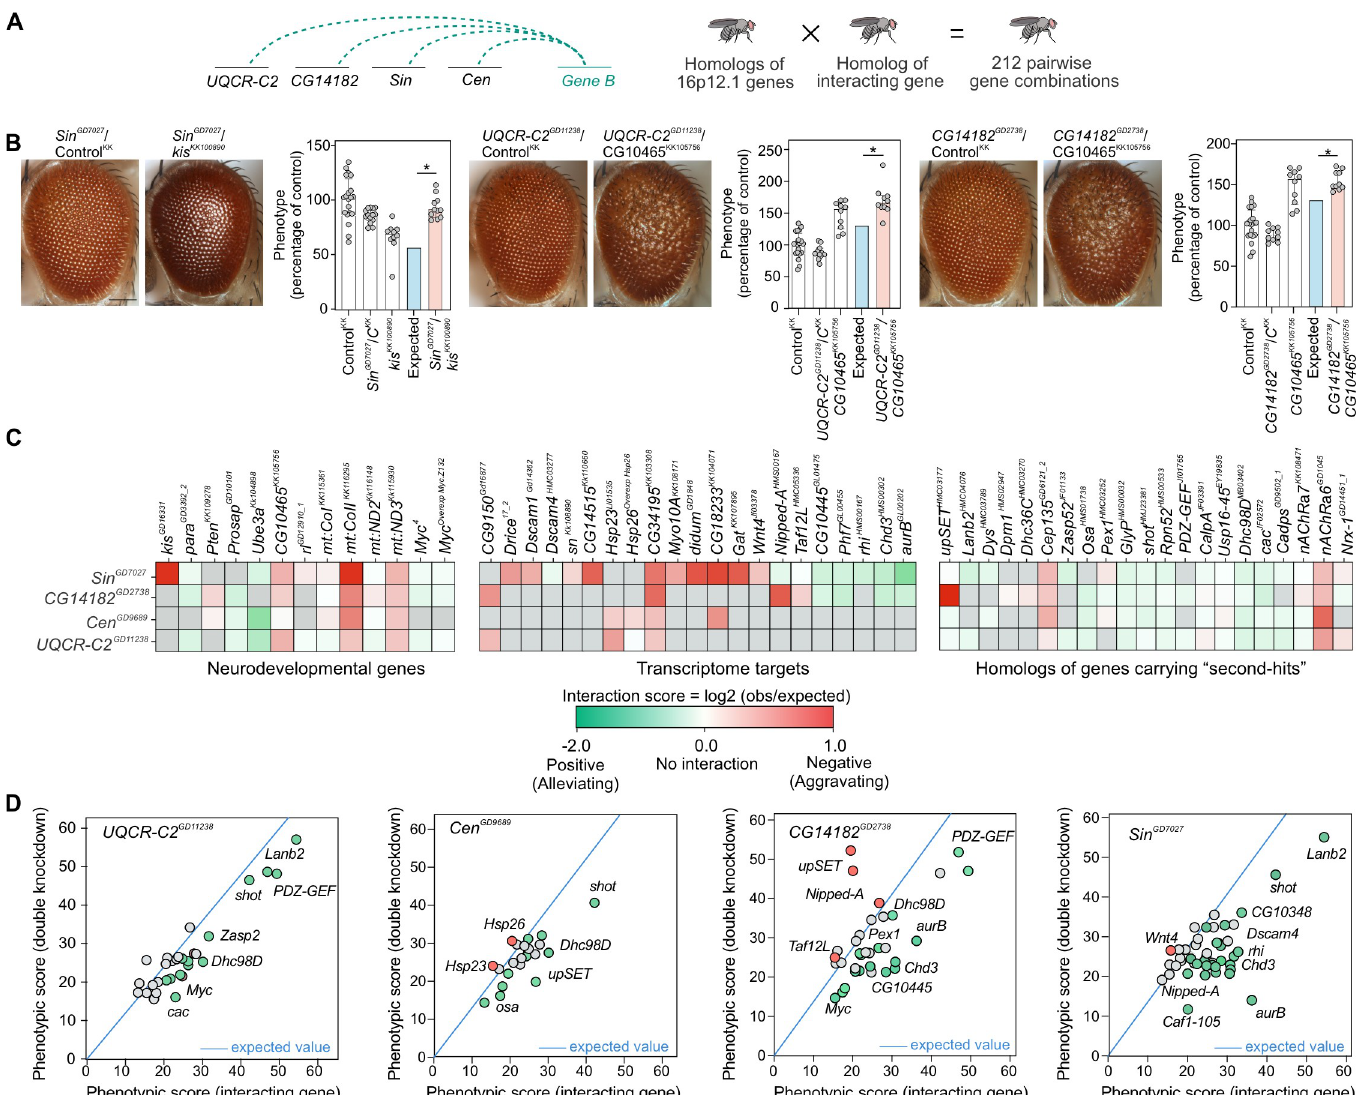
Fig 4. Homologs of 16p12.1 genes show complex interactions with conserved neurodevelopmental genes and homologs of patient-specific “second-hit” genes. (A) We evaluated how homologs of genes outside of the CNV region ( Gene B ), including genes carrying “second-hit” variants in children with the 16p12.1 deletion, genes within conserved neurodevelopmental pathways, and transcriptome targets, affect the phenotypes observed for homologs of 16p12.1 genes. We crossed eye-specific recombinant lines for each homolog with a total of 124 RNAi, mutant or overexpression lines for 76 interacting genes to test a total of 212 pairwise gene combinations. ( B ) Representative brightfield images of Drosophila adult eyes for recombinant lines of 16p12.1 homologs crossed with background-specific controls (Control KK , also represented as C KK ) or RNAi lines for kis and CG10465 , are shown as examples of genetic interactions between the 16p12.1 homologs and homologs of neurodevelopmental genes. Bar plots show normalized phenotypes (median ± interquartile range) for 16p12.1 recombinant lines crossed with background-specific control or with RNAi lines for interacting genes. Sin GD7027 negatively interacted with kis KK100890 and led to a more severe phenotype (two-tail one-sample Wilcoxon signed rank test with Benjamini-Hochberg correction, n = 11, � p = 0.012, in red) than expected (in blue) under a multiplicative model. Similarly, CG10465 KK105756 negatively interacted with UQCR-C2 GD11238 (n = 10, � p = 0.024) and CG14182 GD2738 (n = 10, � p = 0.015), leading to more severe eye phenotypes than expected. Phenotypes are represented as percentage of average, i.e. normalized to Flynotyper scores from control flies carrying the same genetic background as the interacting gene. Scale bar represents 100 μ m. ( C ) Heatmaps show interaction scores calculated as the log 2 ratio between the average of observed and expected phenotypic scores. Positive scores represent negative aggravating genetic interactions (in red), while negative scores represent positive alleviating interactions (in green). Grey boxes indicate pairwise crosses that were not tested or were not validated by multiple lines. A complete list of interaction scores is provided in S4 File . ( D ) Scatter plots depict interactions tested for 16p12.1 homologs. The plots show the average phenotypic score of the interacting gene on the x-axis, and the average observed phenotypic score for the pairwise knockdown on the y-axis. The blue line represents the expected phenotypic score of the pairwise knockdown calculated for each 16p12.1 homolog (value of first hit crossed with control, such as UQCR-C2 GD11238 × Control BL ), and all possible phenotypic scores (ranging from 0 to 60) of the interacting genes are represented on the x- axis. All positive and negative (validated or potential) interactions are represented in green and red, respectively, and fly lines of genes with no significant interactions are shown in grey. Only lines from the BDSC stock center are represented here; S17 Fig shows scatter plots representing VDRC stock lines.